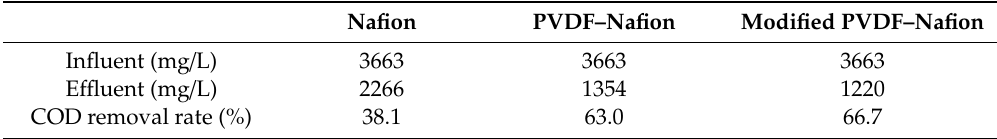
Table 4. Influent and e ffl uent COD of MFCs with di ff erent membranes (with carbon felt electrode).